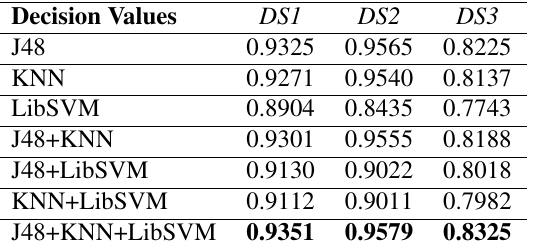
Table 7. The results of the decision values with the weight val- ues { 1/6, 1/3, 1/2 } . Decision